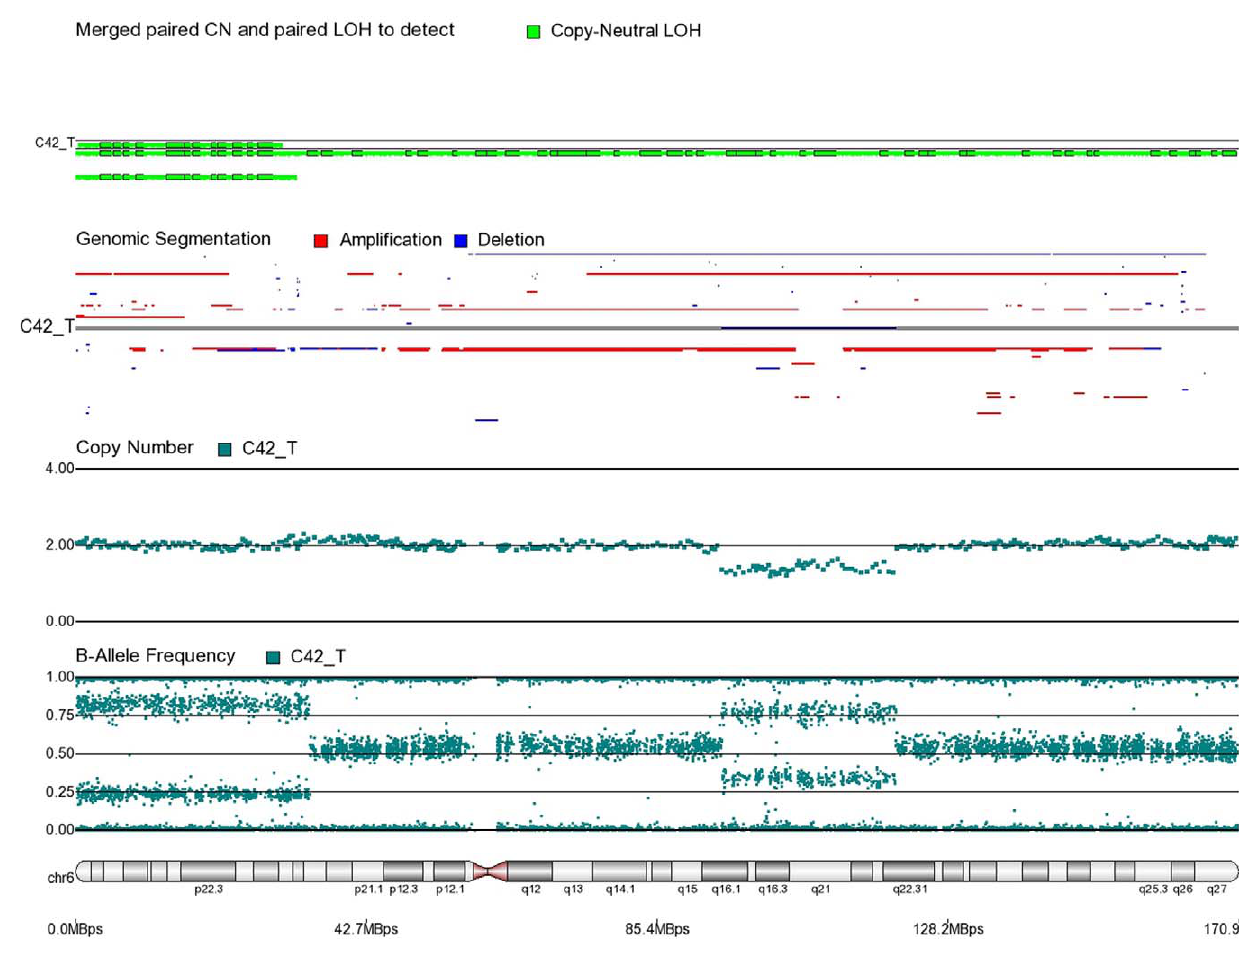
Figure 11. Mosaic cnLOH in chromosome 6 of CRC tissue sample C42_T. The cnLOH occurs in 6p where BAF=0.25, 0.75 and CN=2. The portion of 6q where CN=1 is mosaic monosomy.